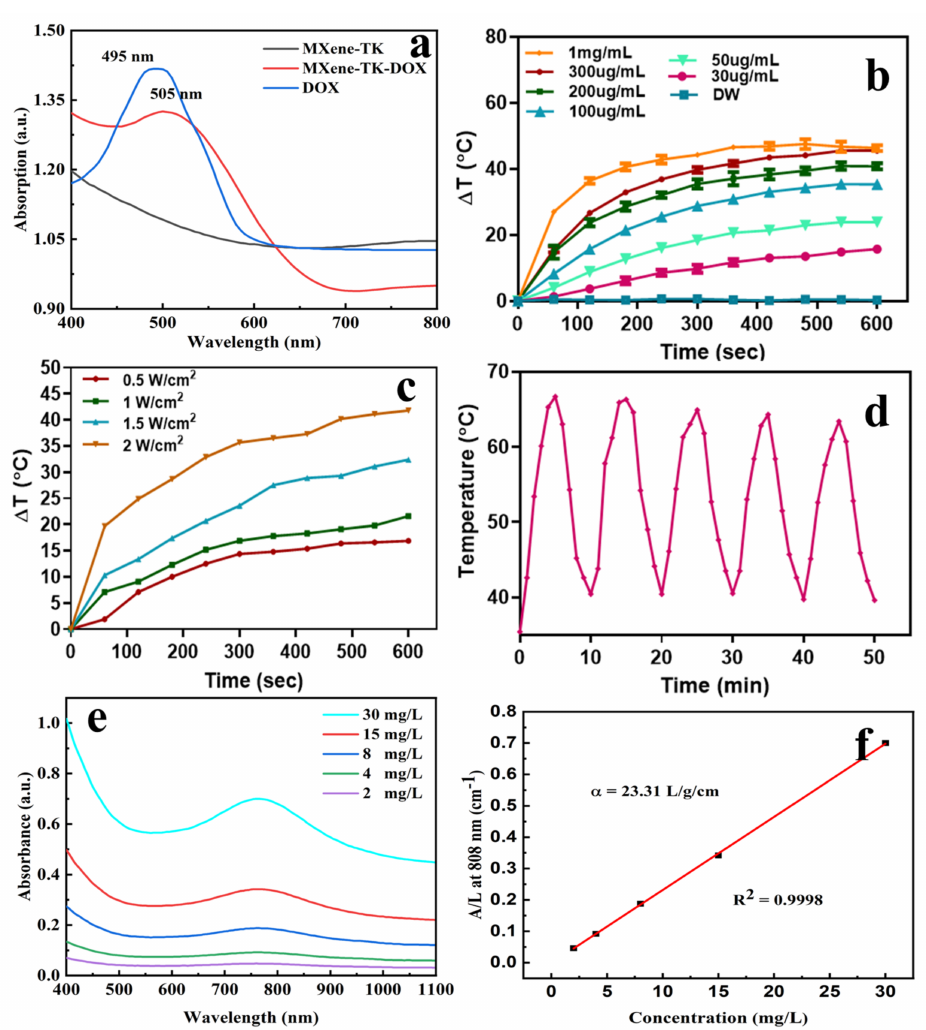
Figure 8. In vitro photothermal-property characterization of the MXene − based nanoparti- cles under various conditions. ( a ) UV − Vis absorption spectra of the pure doxorubicin, MXene − TK, and MXene − TK − DOX nanoparticles. ( b ) Photothermal conversion profile of the MXene − TK − DOX@PDA nanoparticles in an aqueous solution after 808 nm laser irradiation (2 W/cm 2 ) at elevated concentrations (0, 30, 50, 100, 200, 300 ug/mL, and 1 mg/mL). ( c ) Pho- tothermal property curve of the MXene − TK − DOX@PDA nanoparticles in an aqueous solution under 808 nm laser irradiation at 300 ug/mL in the presence of different laser densities (0.5, 1, 1.5, and 2 W/cm 2 ). ( d ) Recycling heating curves of the MXene − TK − DOX@PDA nanoparticles in an aqueous solution after 808 nm laser irradiation at 2 W cm − 2 for five laser on/off cycles. ( e ) UV − Vis − NIR absorption spectra of the MXene nanosheets at diverse concentrations (2, 4, 8, 15, and 30 mg/L). ( f ) Extinction coefficient of the MXene